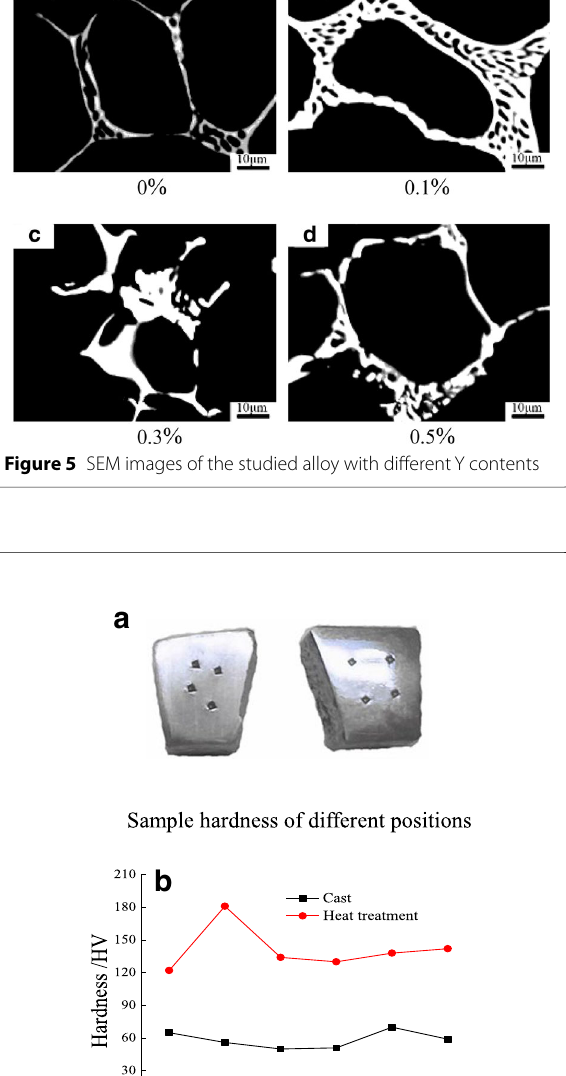
Figure 6 Effects of changes in